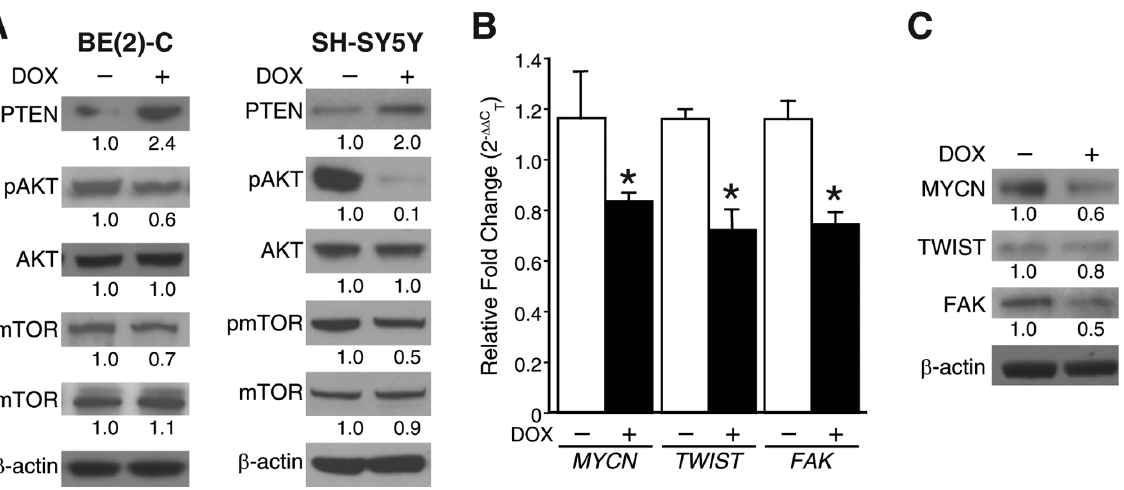
Figure 2. GRP silencing on PTEN/AKT/mTOR signaling and MYCN, TWIST, FAK. (A) BE(2)-C/Tet/shGRP ( + DOX) cells and SH-SY5Y/Tet/shGRP ( + DOX) cells had an increase in PTEN expression along with correlative decreases in pAKT and pmTOR expression when compared to control cells (without doxycycline; -DOX). (B) Doxycycline-induced GRP silencing in BE (2)-C/Tet/shGRP cells decreased the mRNA levels of MYCN , TWIST and FAK by , 50–60% as assessed by QRT-PCR (mean 6 SEM; *= p , 0.05 vs. without DOX). (C) Immunoblotting confirmed the decreases in the protein levels of MYCN, TWIST and FAK after GRP silencing ( + DOX) in comparison to untreated (-DOX) BE (2)-C/Tet/shGRP cells. b -actin was used as a loading control.